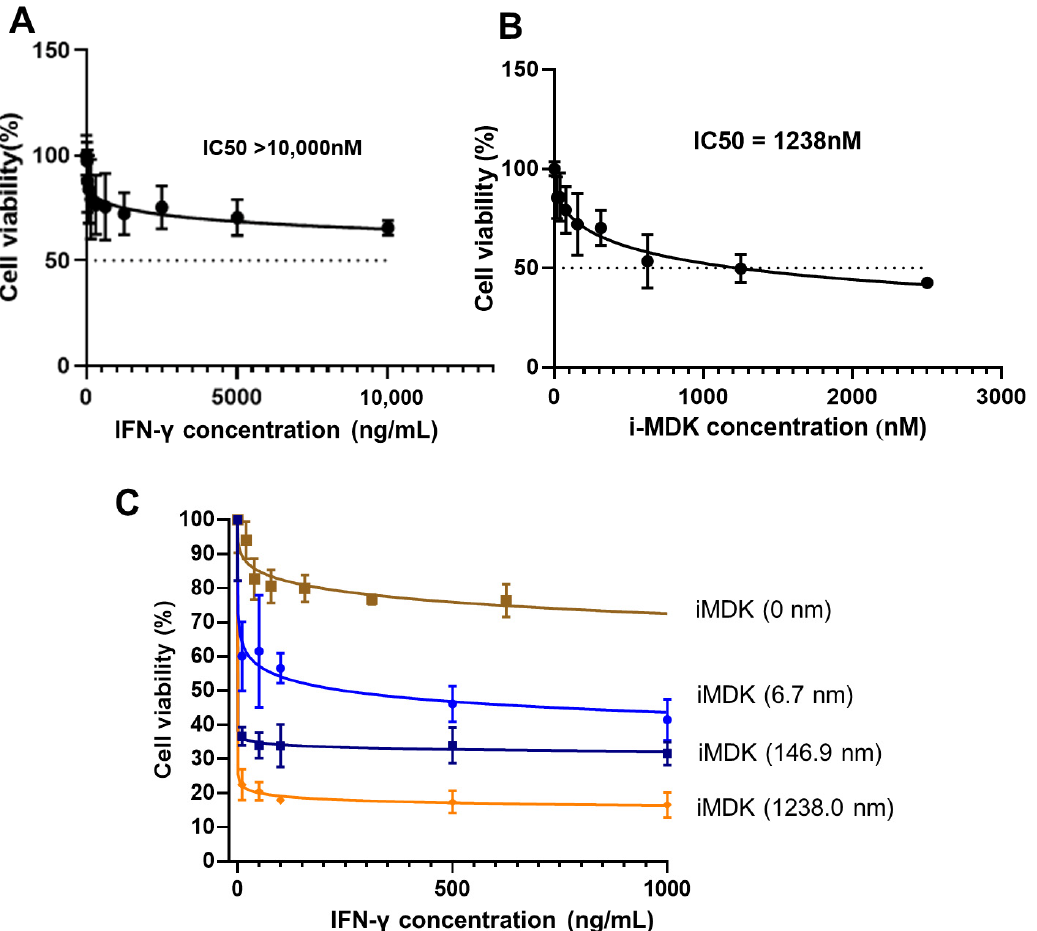
Figure 4. MDK inhibition potentiates the tumoricidal effect of IFN- γ in SKOV3 cells. ( A ) CCK8 analysis of the effect of IFN- γ on the cell viability of SKOV3 cells. ( B ) CCK8 analysis of the effect of iMDK on the cell viability of SKOV3 cells. ( C ) CCK8 assays to determine the effect of the combined usage of different doses of iMDK on the tumoricidal effect of IFN- γ . Data are represented as mean ± SD, n = 3. Table 1. CompuSyn calculation of the combination indexes between IFN- γ and iMDK.